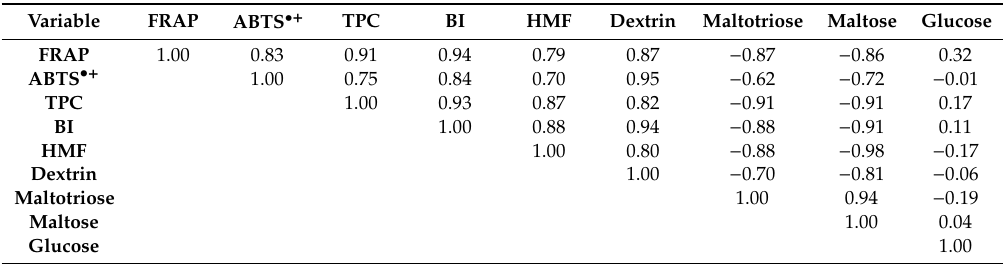
Table 4. Analysis of the correlation between the antioxidant activity, total polyphenol content, color of the wort, 5-hydroxymethylfurfural (HMF) content and the carbohydrate profile of wort produced with 20–40% dark chocolate